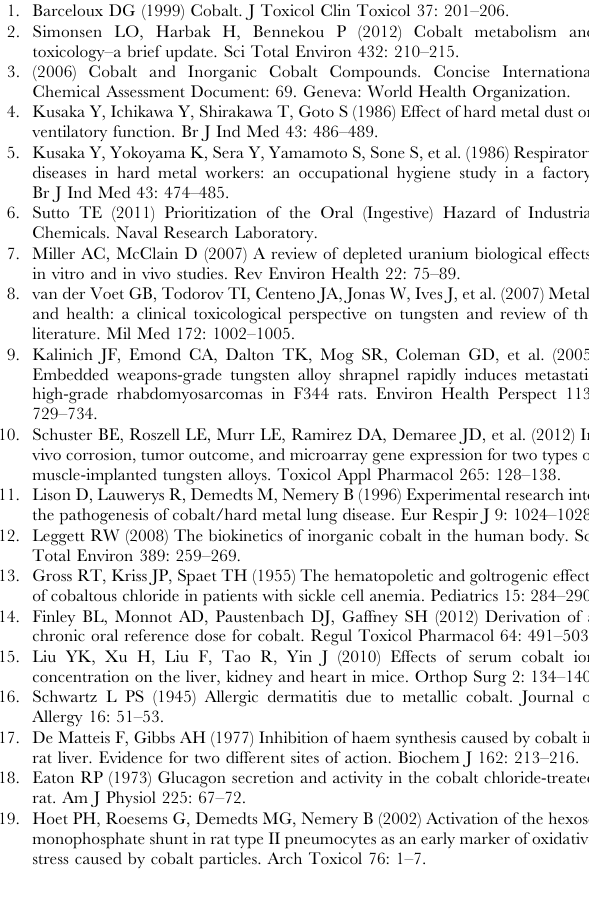
Table S2 Proteins changing in abundance. We identified 56 proteins that changed in abundance, of which 43 increased and 13 proteins decreased, with a p-value , 0.05 and a fold changed cutoff of 1.5 in at least one sample. Table S3 Significant transcription factors. IPA transcription factors that are predicted to be activated or inhibited are listed on separate worksheets for the transcriptomic, proteomic, and combined data. We considered an activation z-score . 2 or ,2 2 to be